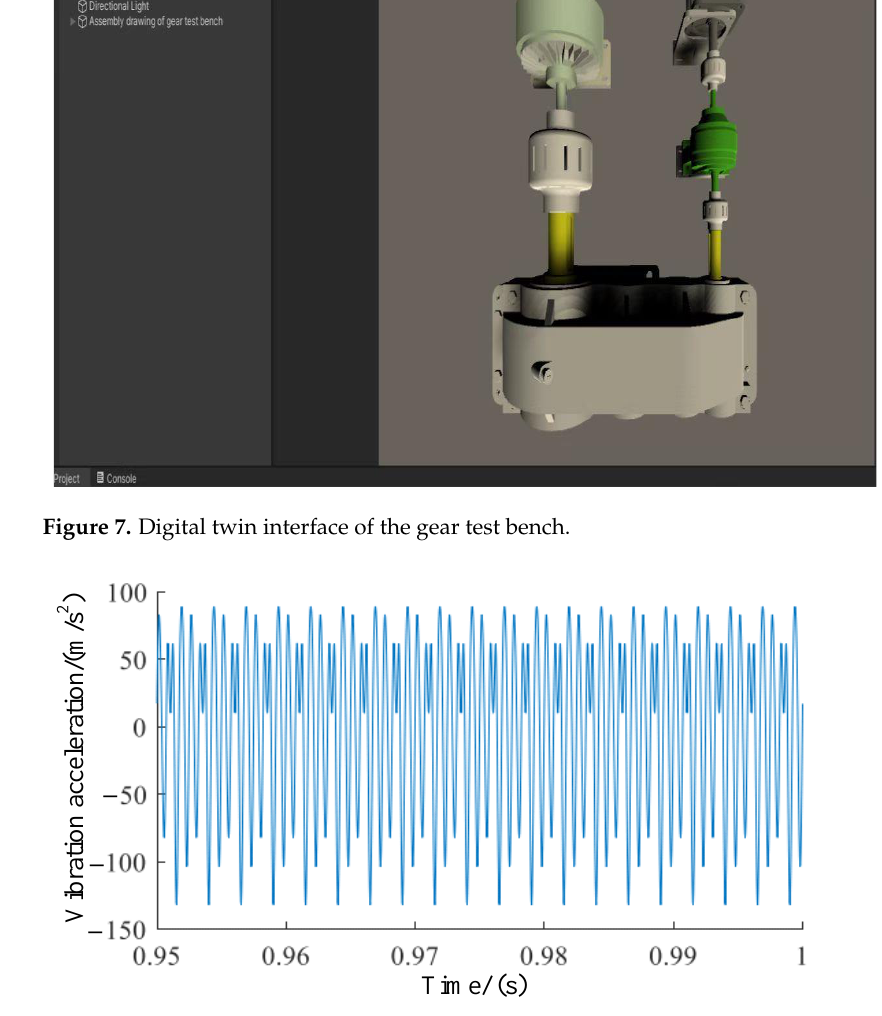
Figure 7. Digital twin interface of the gear test bench.